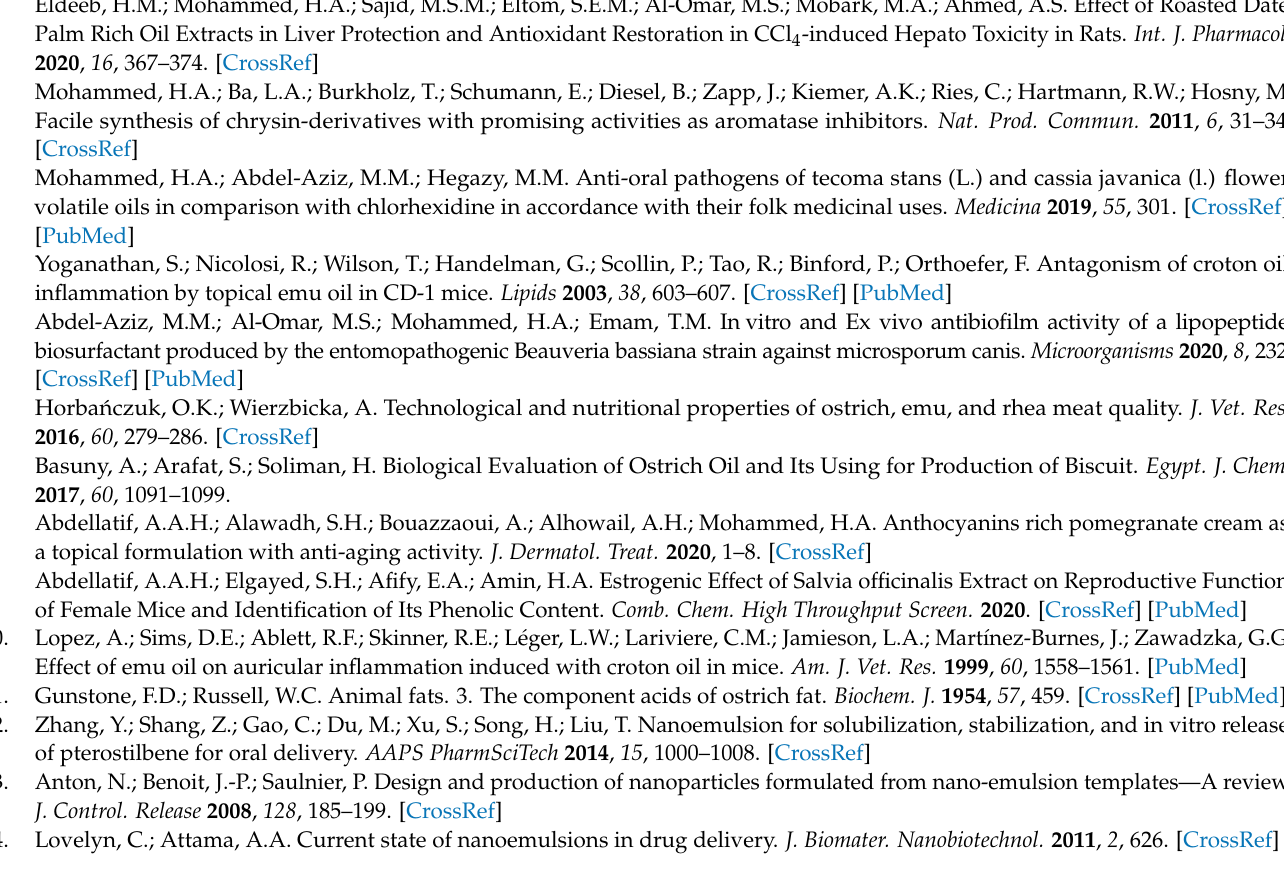
Supplementary Materials: Figure S1: H-NMR spectrum of compound 1 ; Figure S2: C-NMR spec- trum of compound 1 ; Figure S3: FT-IR spectrum of compound 1 ; Figure S4: FT-IR spectra of the Na + -salt of compound 1 ; Table S1: The histological changes in skin—thickness measured in (mm).; Table S2: The anti-inflammatory activity result of control group in Plethysmometer test.; Table S3: The ant-inflammatory activity result of 30 mg/kg of oral ibuprofen suspension in Plethysmometer test.; Table S4: The anti-inflammatory activity result of 10 mL/kg of The γ -lactone nano emulsion base in Plethysmometer